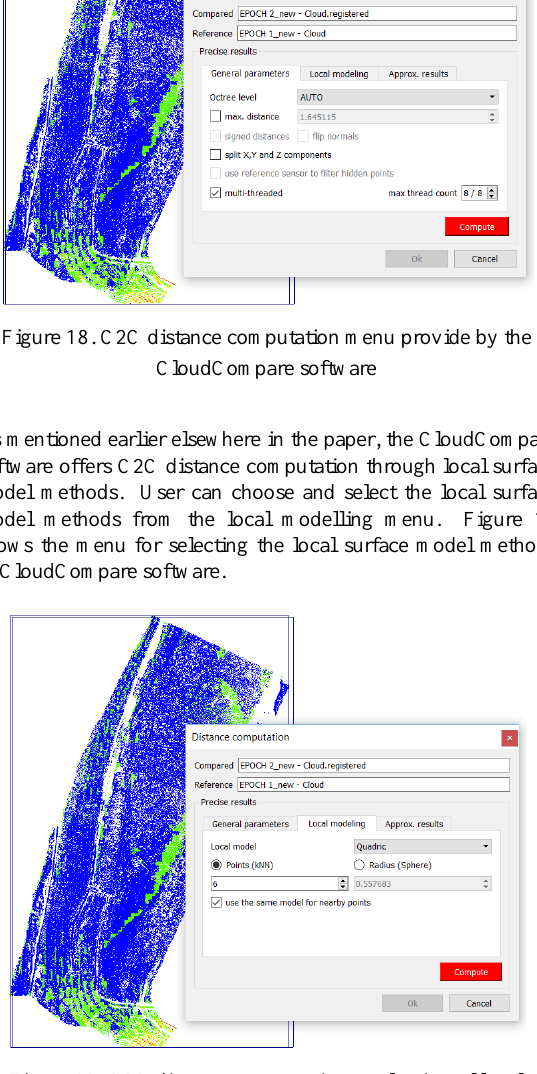
Figure 19. C2C distance computation – selection of local surface